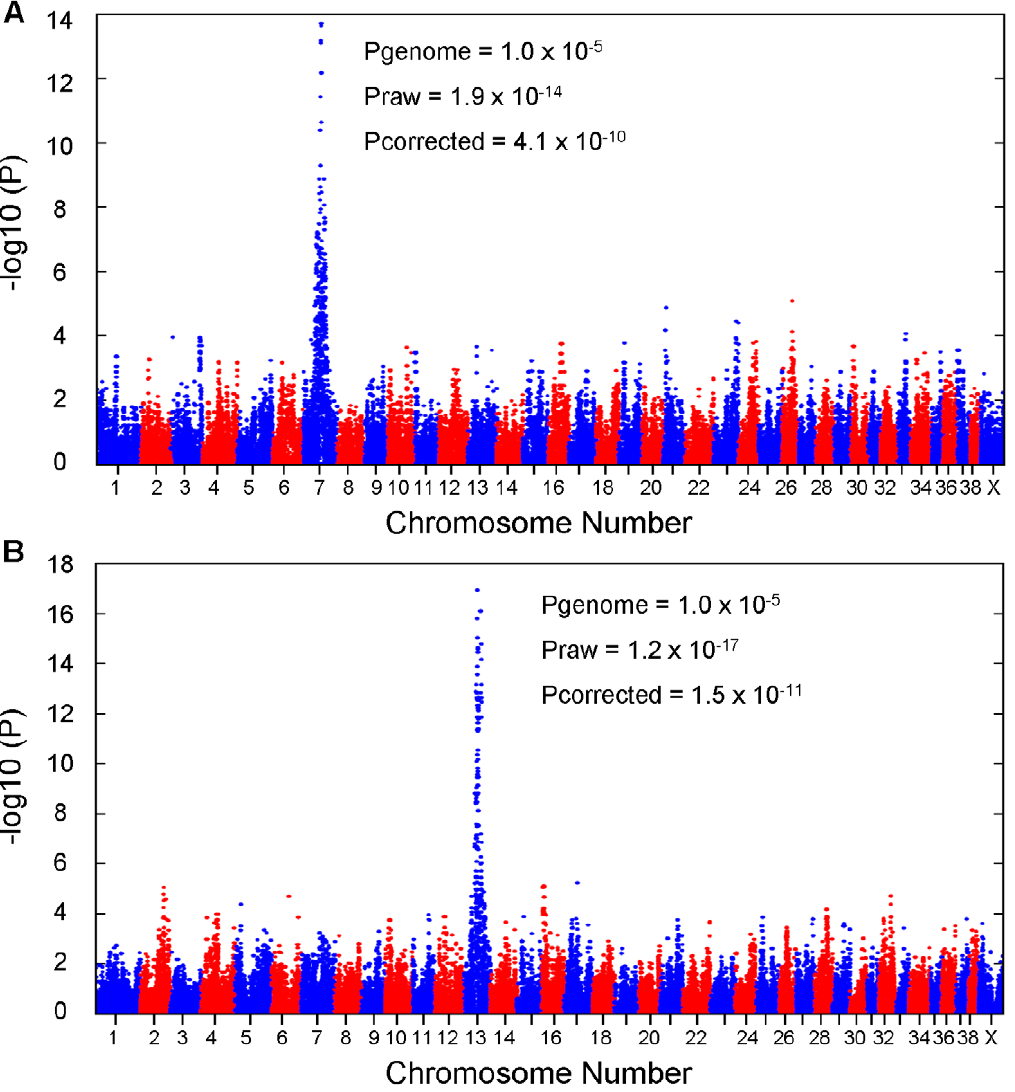
Figure 1. Results of genome-wide association studies. For (A) EF and (B) CKCSID.